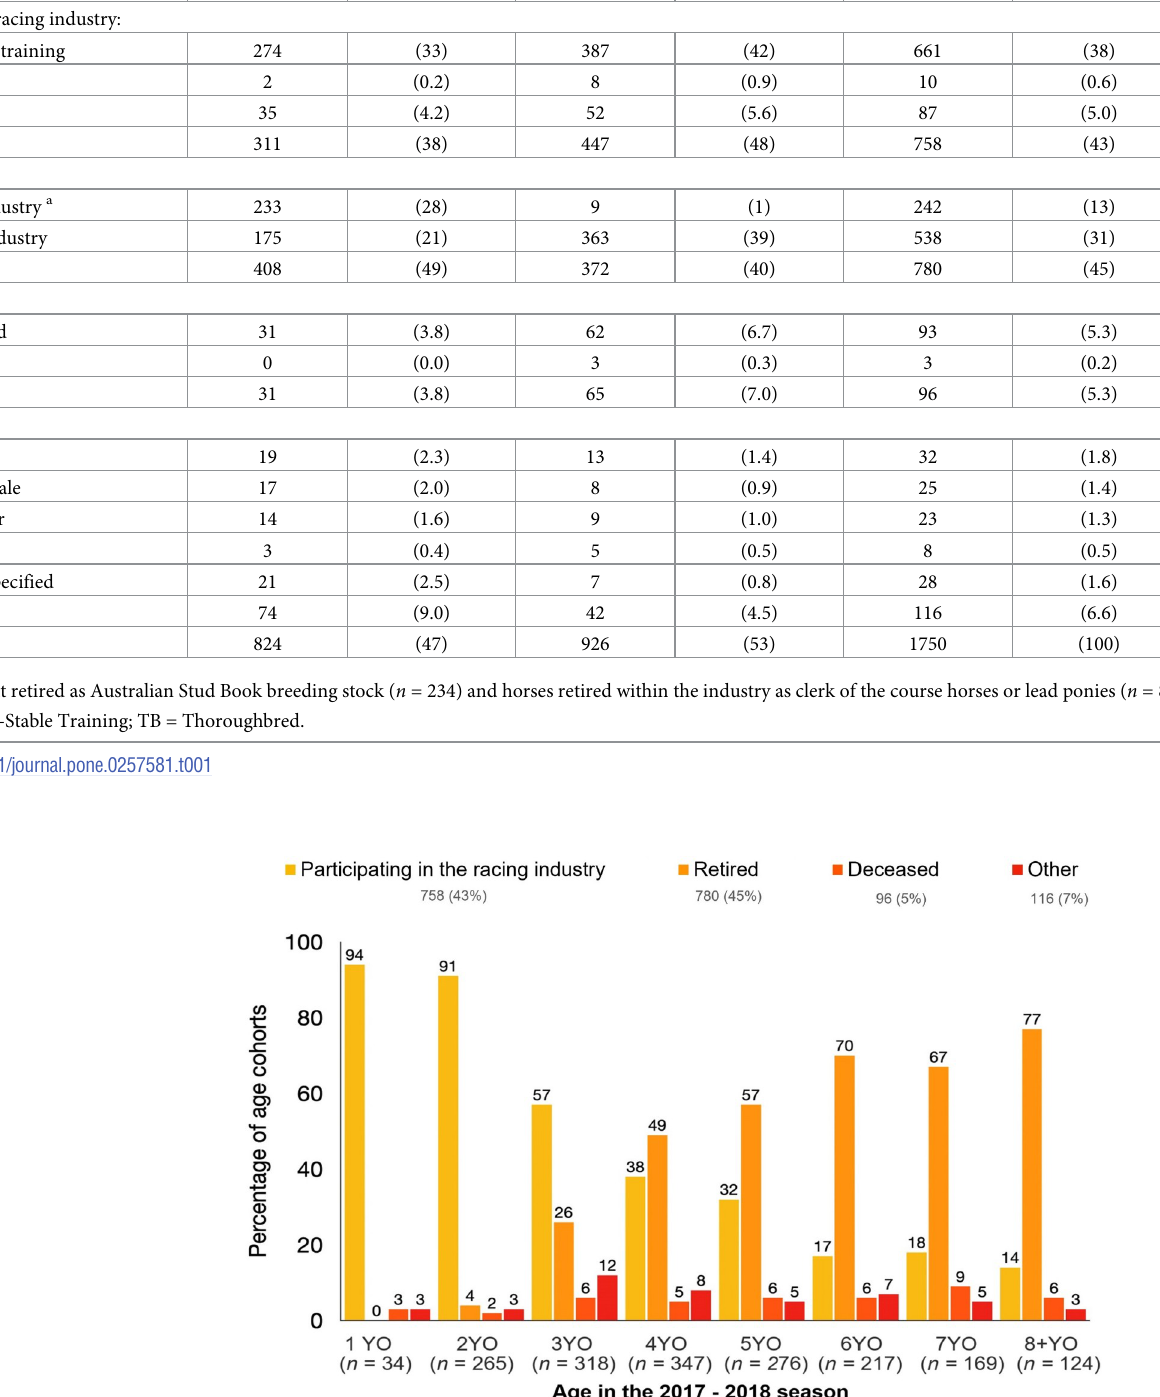
Table 1. Survey outcomes stratified by sex for 1,750 study horses classified as inactive in the 2017–2018 Australian Thoroughbred racing season. Outcome